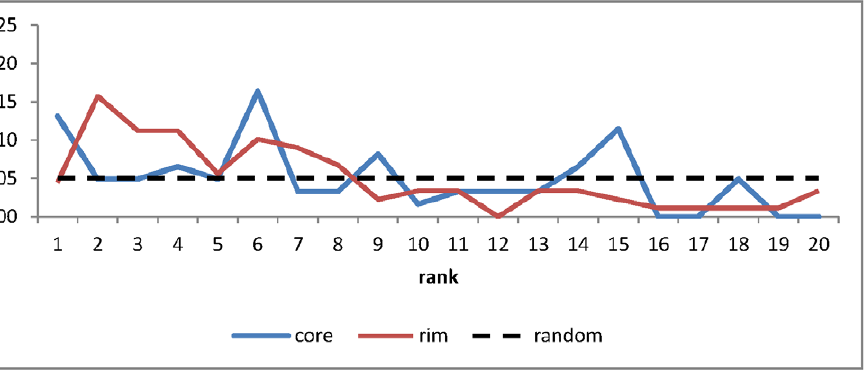
Figure 6. Distributions of the predicted ranking of the CDR amino acids in the antibody-VEGF complex interfaces. The x-axis shows the predicted ranking of the CDR amino acids in the five antibody-VEGF complex interfaces as shown in Figure 5. Detailed prediction results are shown in Table S9. The y-axis shows the percentage of the CDR amino acids predicted with the ranking shown in x-axis. The red line shows the distribution for the amino acids in the core interface, while the blue line shows the distribution for the amino acids in the rim interface. These two distributions are compared with random distribution shown as the flat dash line in the figure.